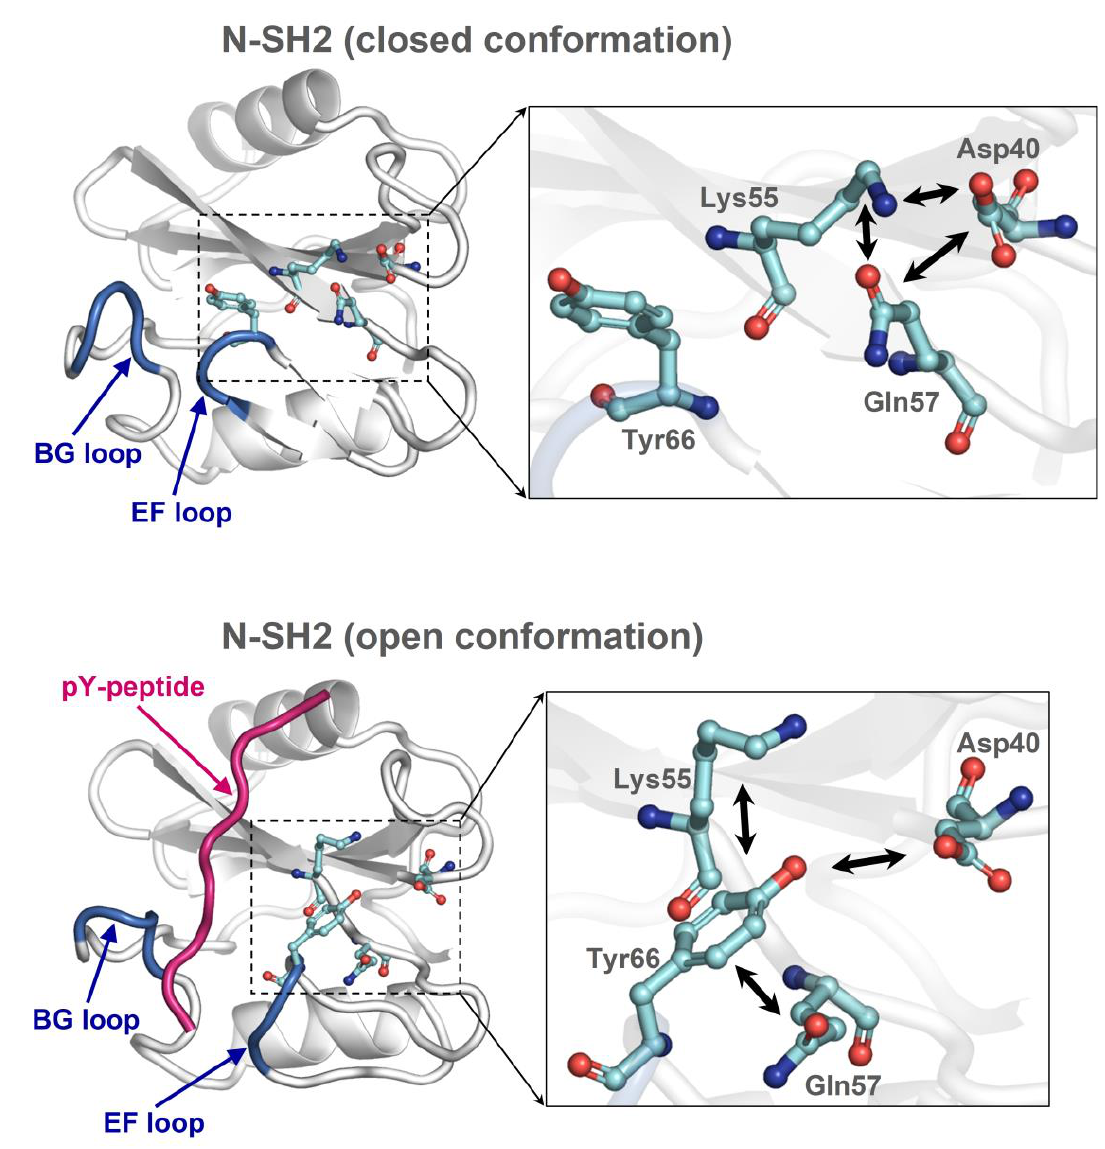
Figure 4. Closed and open conformations of the N-SH2 domain of the SHP2 tyrosine phosphatase. ( top ) Closed conformation (N-SH2 domain isolated from PDB 2SHP). ( bottom ) Open conformation with a bound pY peptide (PDB 1AYA). Shown is the Tyr66 conformational switch and the other critical residues Asp40, Lys55, and Gln57, whose mutual interactions (indicated by double arrows) determine the closed or open conformation, as highlighted by Guvench et al.